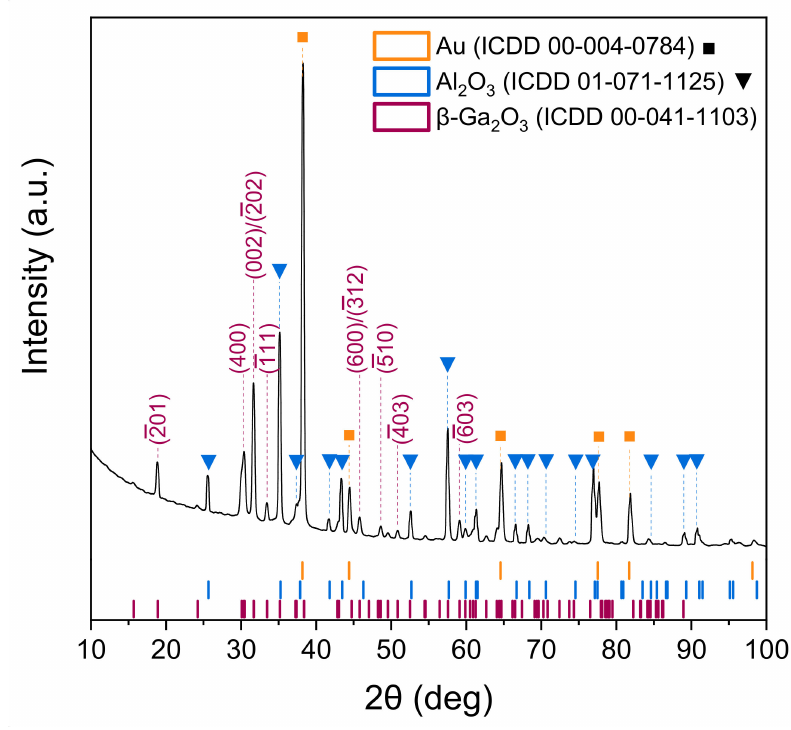
Figure 4. X-ray diffractogram of β -Ga 2 O 3 epitaxial